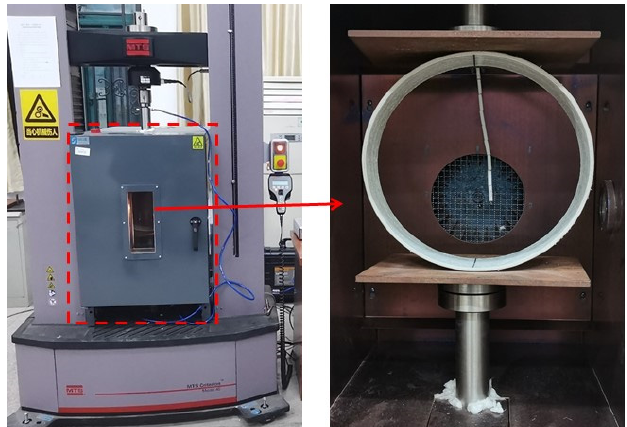
Figure 3. Schematic diagram of determination for external loading properties by parallel-plate loading.